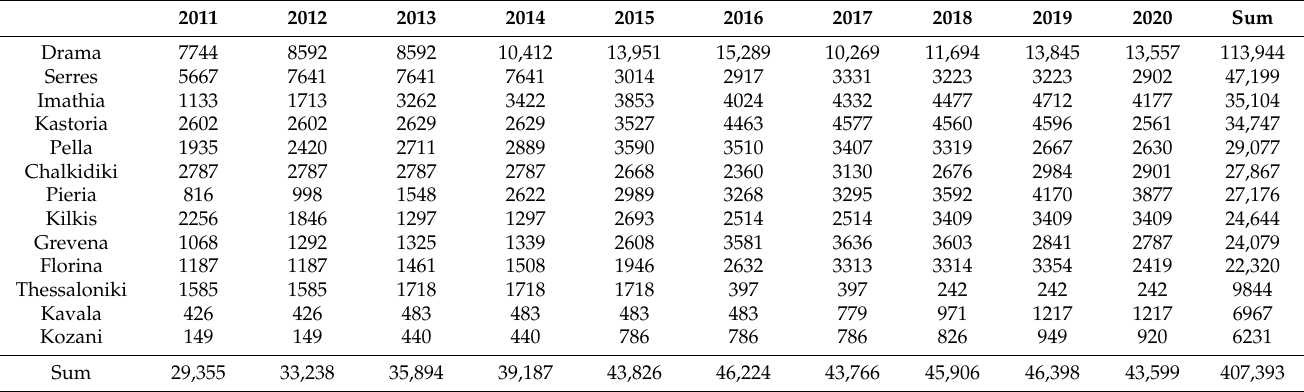
Table A2. Estimated treated area inside forest districts in hectares for the period 2011–2020, grouped per year and for each of the 13 prefectures of Macedonia, Greece.